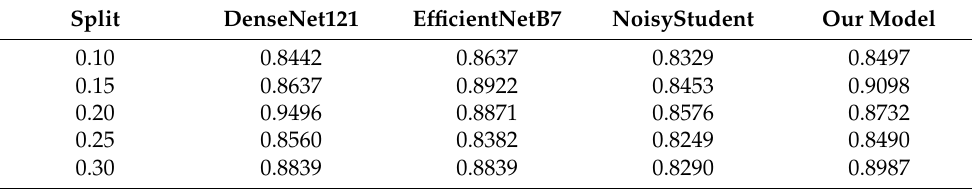
Table 4. F1-Scores of pre-trained models and proposed model at various split ratios.